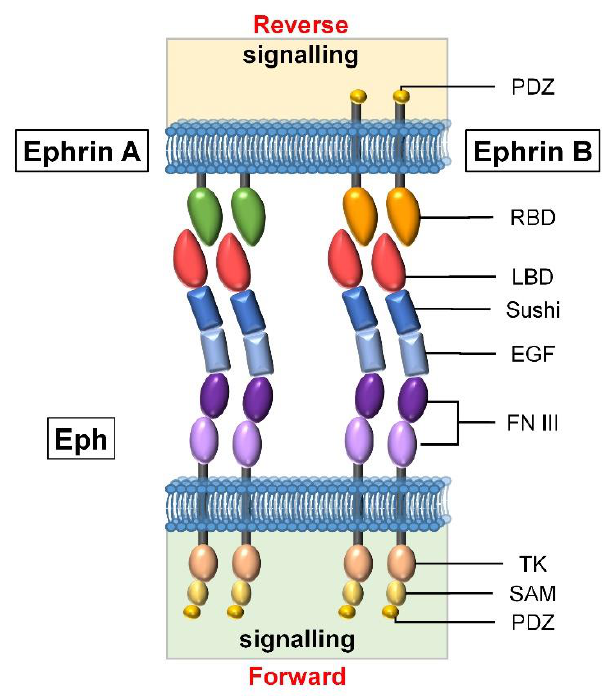
Figure 1. Eph and ephrin molecules. The two families of ephrins present an extracellular receptor-binding domain (RBD) that interacts with Eph, but while ephrin-A ligands have a GPI-binding domain, ephrin-B are transmembrane proteins with an intracellular kinase domain. Eph are transmembrane proteins with an extracellular region composed of a ligand-binding domain (LBD) to interact with ephrins; a Cys-rich region formed by sushi and epidermal growth factor (EGF)–like domains; and two fibronectin-type III (FN III) repeats. This is followed by a transmembrane region, the Tyr kinase domain (TK), the sterile alpha motif (SAM), and the PDZ domain, forming the intracellular side of Eph receptors (modified from [37] ).